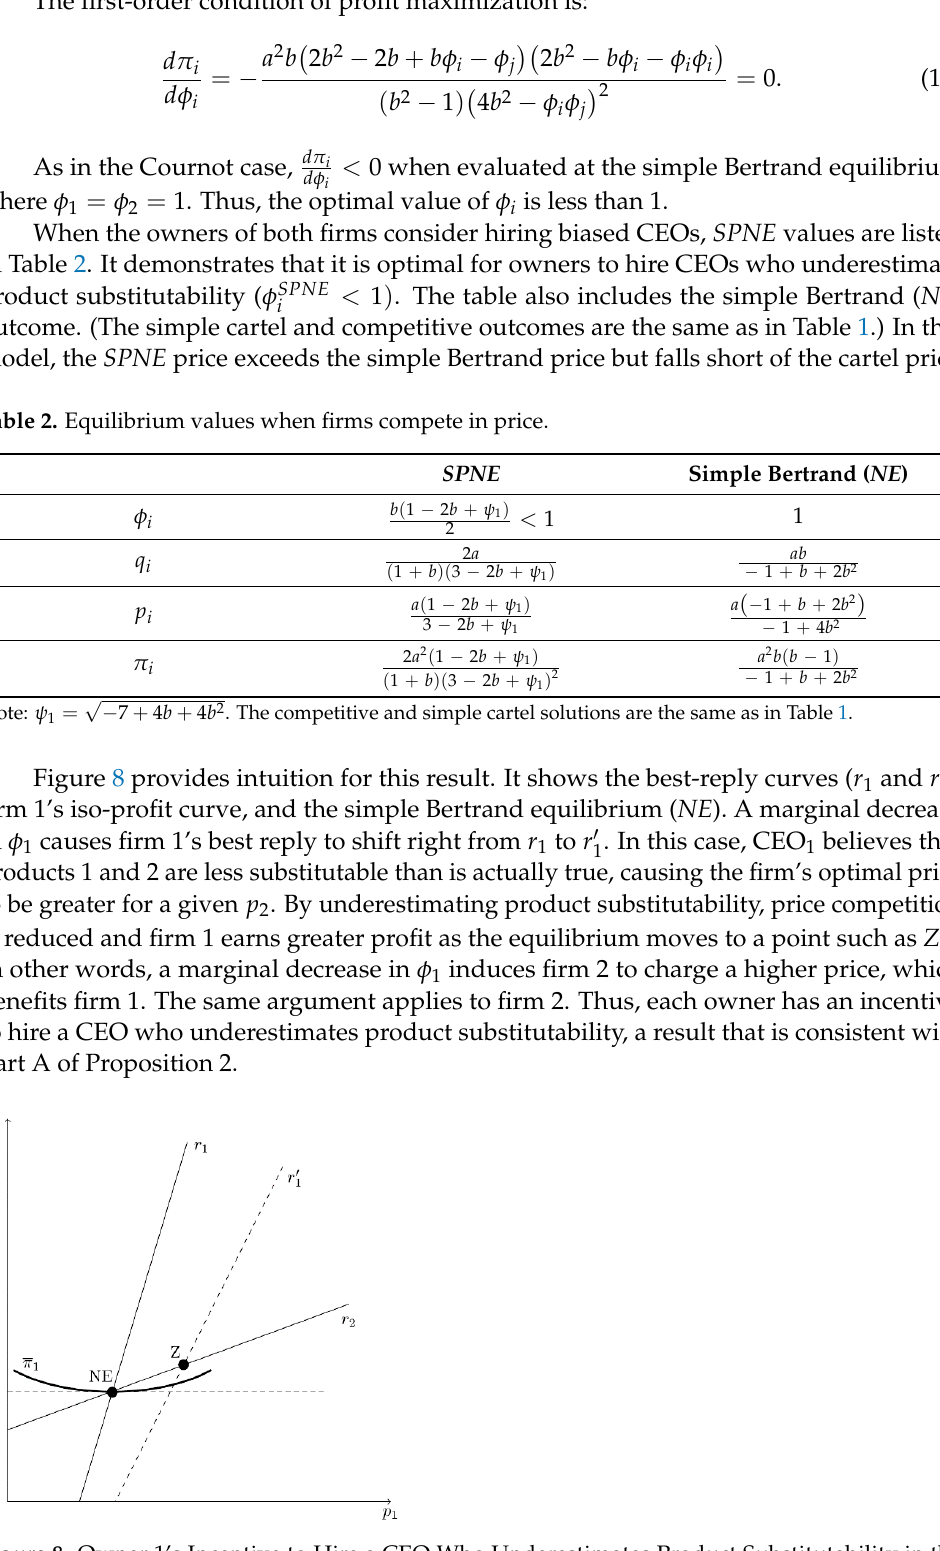
Figure 9. The SPNE When Owners Hire CEOs Who Underestimate Product Substitutability in the Bertand Model. Figure 10. Owner 1’s Incentive to Hire a CEO Who Overestimates Product Substitutability in the Bertrand Model When Overestimation Affects the Best ‐ Reply Curves of Both Firms.